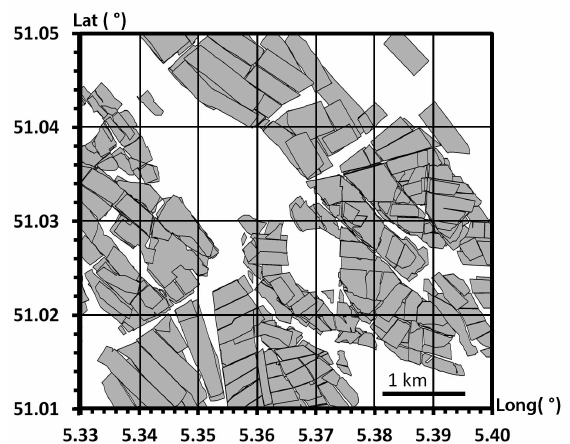
Figure 1. Map of longwall panels in area studied, i.e., between a lat- itude of 51.01–51.05 ◦ N, and between a longitude of 5.33–5.40 ◦